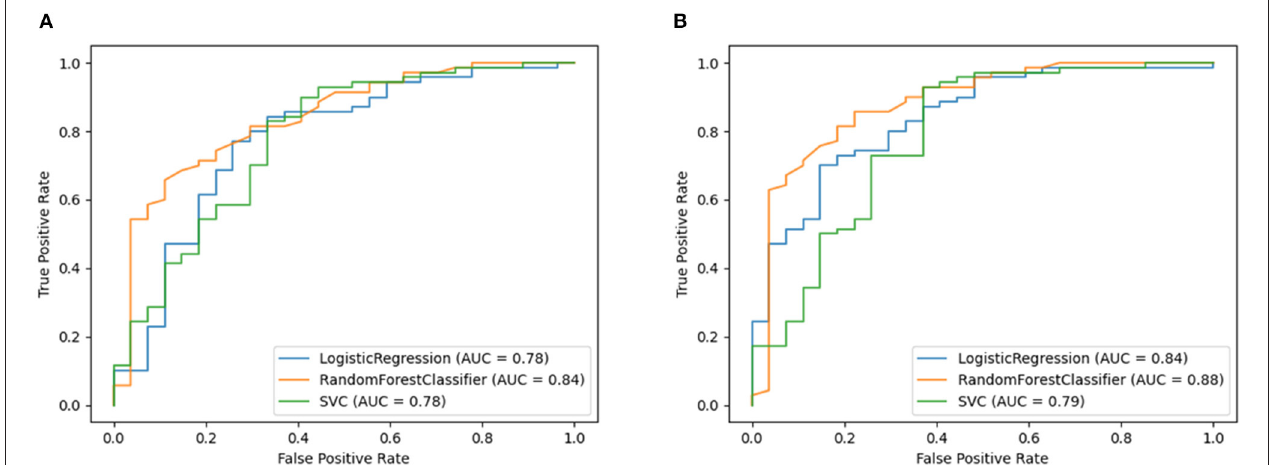
FIGURE 3 | Receiver operating characteristic curve plots of Model 3 and Model 3P . Model 3 used only features extracted from breath and speech parts and Model 3P included biological factors (sex, weight, and height) with the features in binary class classification models. Predicted binary classification was defined based on FEV 1 %